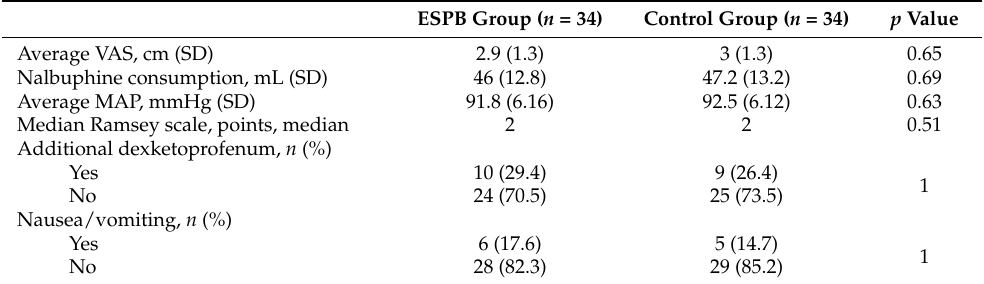
Table 3. Postoperative characteristics of the analyzed groups. VAS, visual analogue scale; MAP, mean arterial pressure.